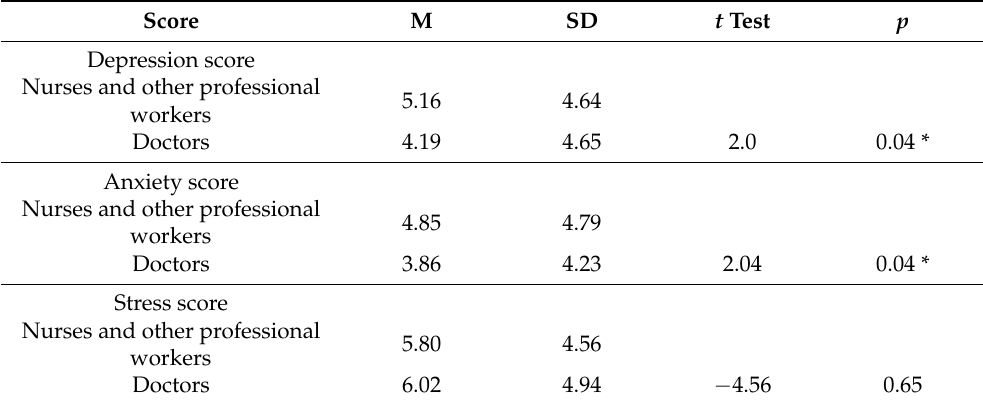
Table 3. Overview of depression, anxiety, and stress levels for doctors (426) and nurses and other professional workers (118) assessed using the Depression Anxiety Stress Scales-21. Score M SD t Test